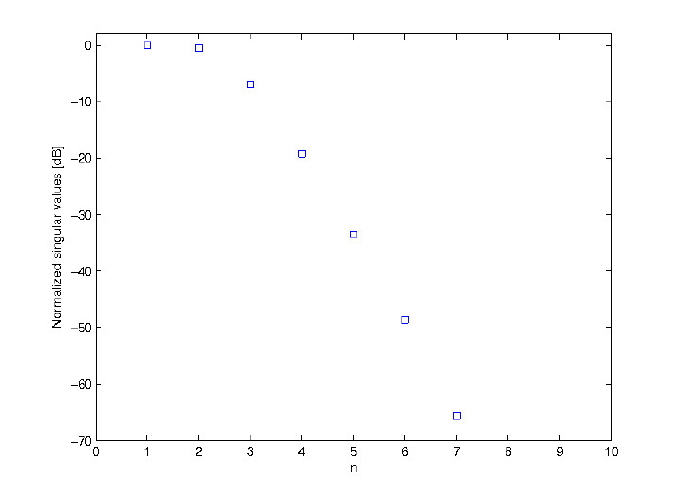
Figure 2. Singular values